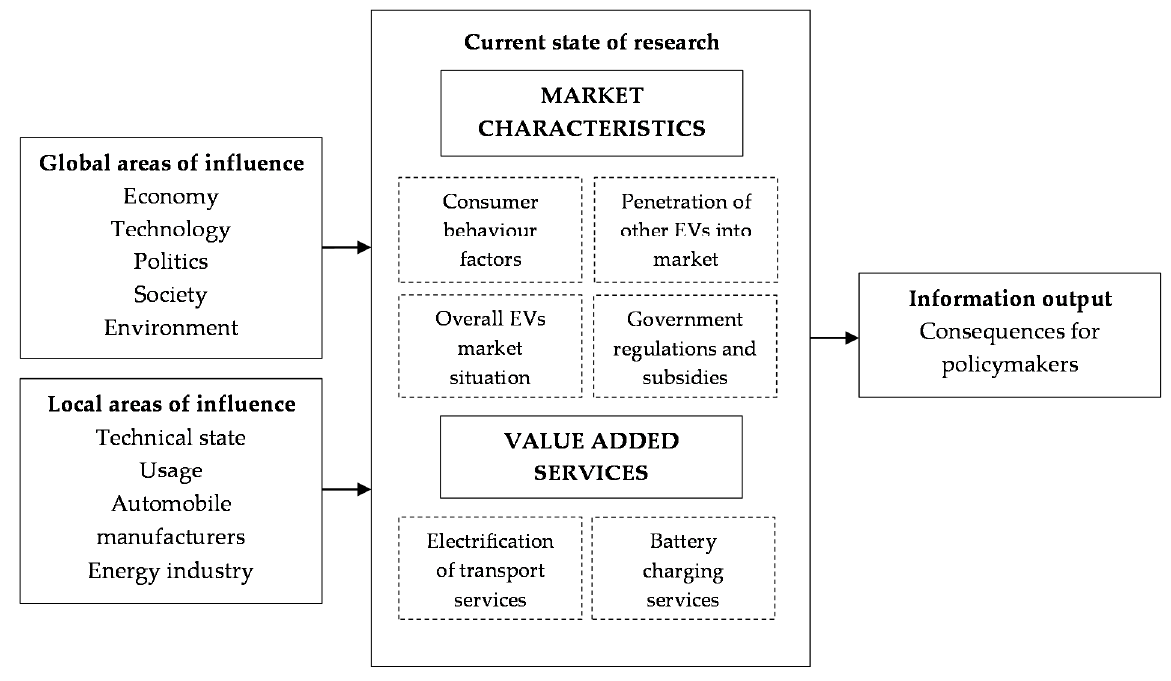
Figure 5. Framework for future research.